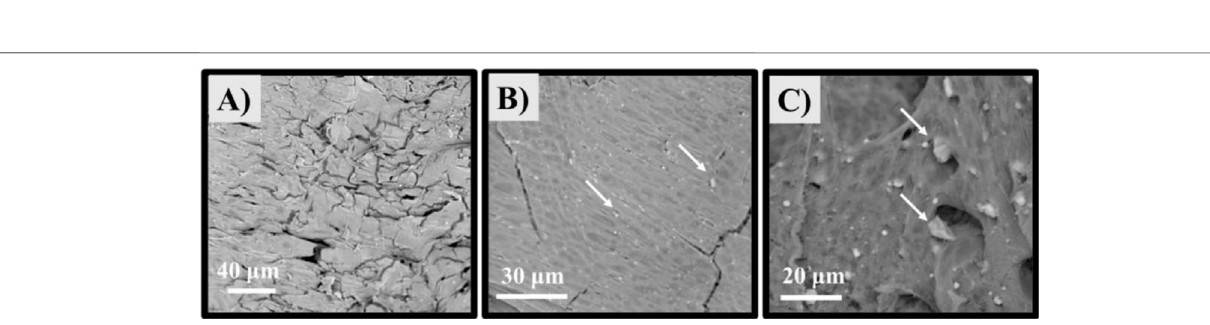
Frontiers in Materials |